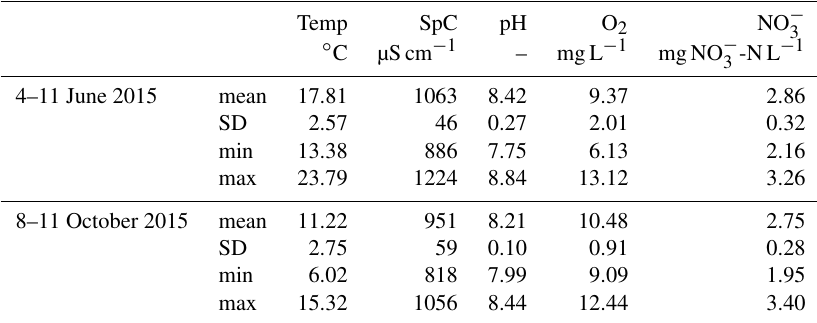
Table 4. Benchmark surface water parameters derived from the continuous sensor records from 4–11 June and 8–11 October 2015: Temp: temperature; SpC: specific conductivity; O 2 : dissolved